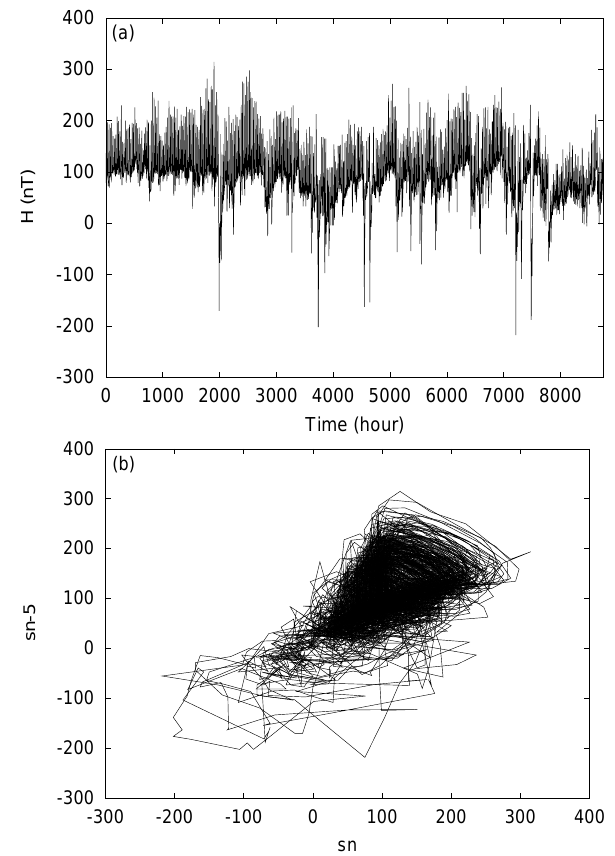
Fig. 1. (a) Time series of the geomagnetic field H. (b) Delay repre- sentation of the time series of